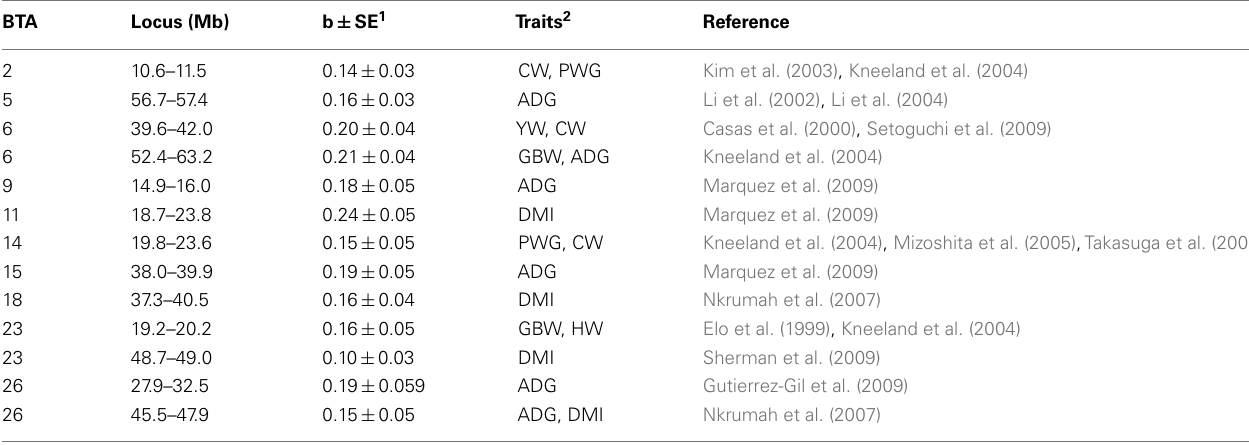
Table 2 | Genomic regions wherein the regression (b ± SE) of number of minor alleles on cumulative selection differential for postweaning gain was significant (FDR < 0.05) in L1 and overlapped with previously identified QTL.